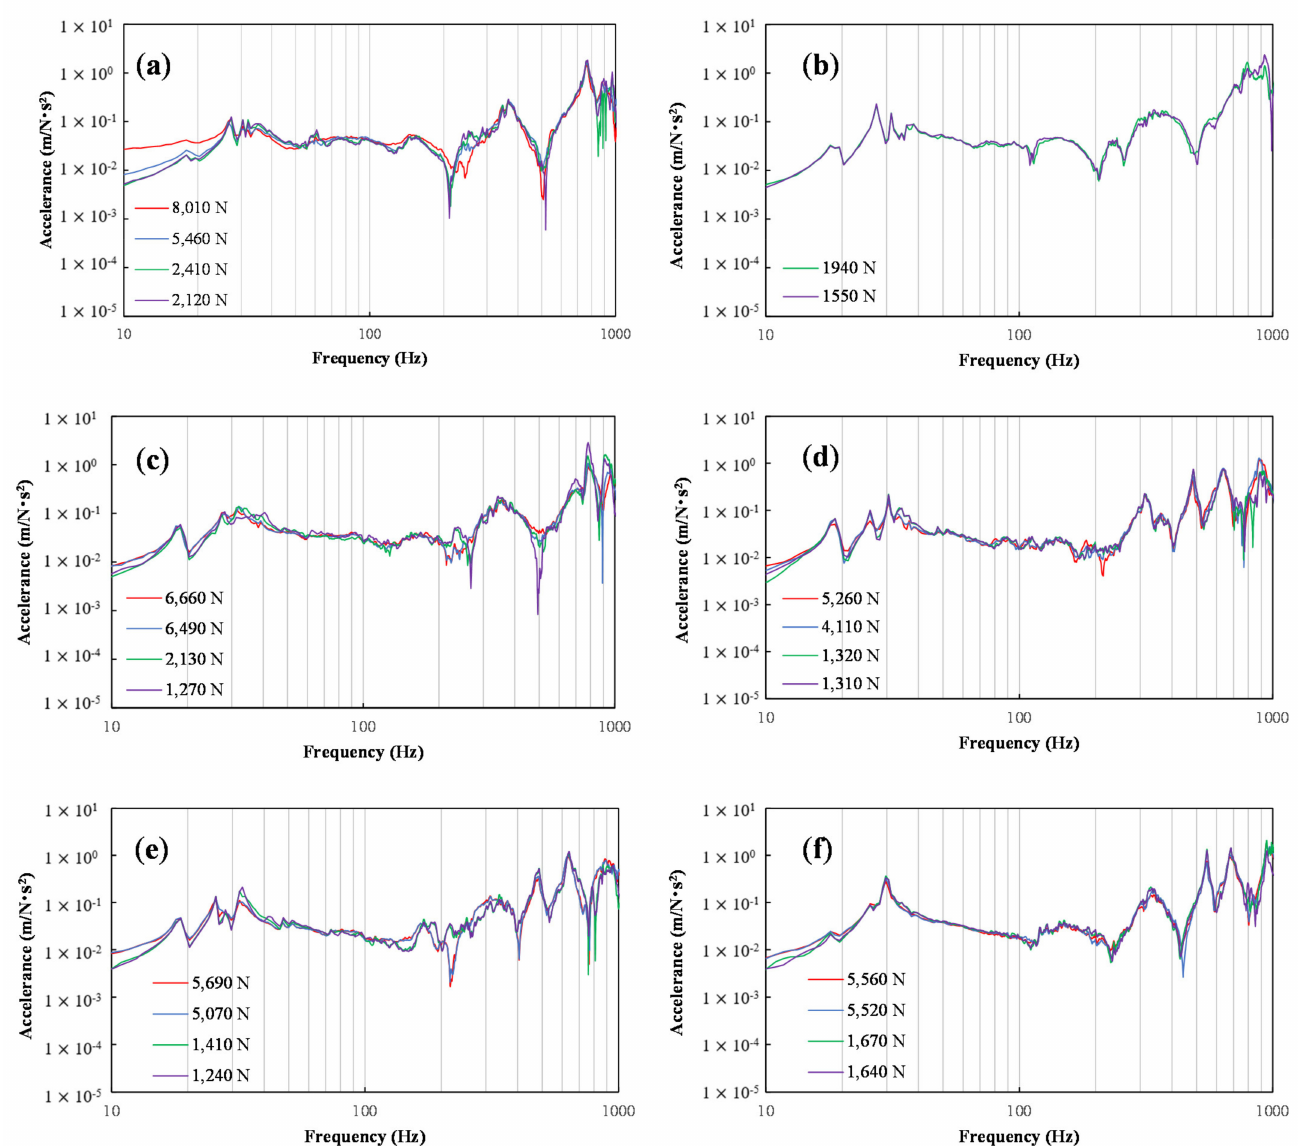
Figure 3. Measurement results for accelerance at six receiving points: ( a ) A 50 , ( b ) B 50 , ( c ) C 50 , ( d ) D 50 , ( e ) E 50 , and ( f ) F 50